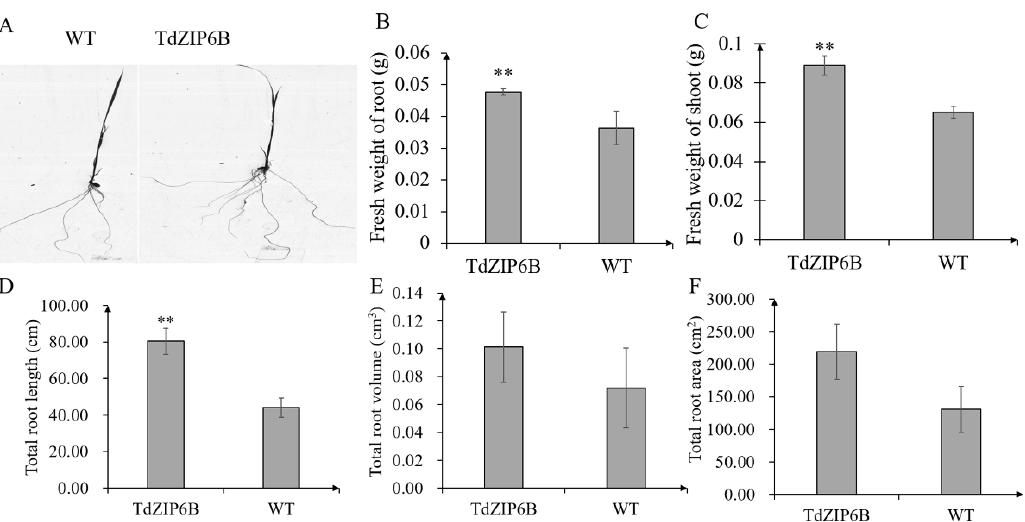
Figure 5. Seedling phenotypes of TdZIP6B-1 overexpression lines (TdZIP6B) and WT plants exposed to normal Zn condition at 14 days. ( A ) Root phenotype; ( B , C ) fresh weight of roots and shoots; ( D – F ) total roots length, volume, and area. Error bars show SE, and the symbol ** indicates statistical differences ( p < 0.01).